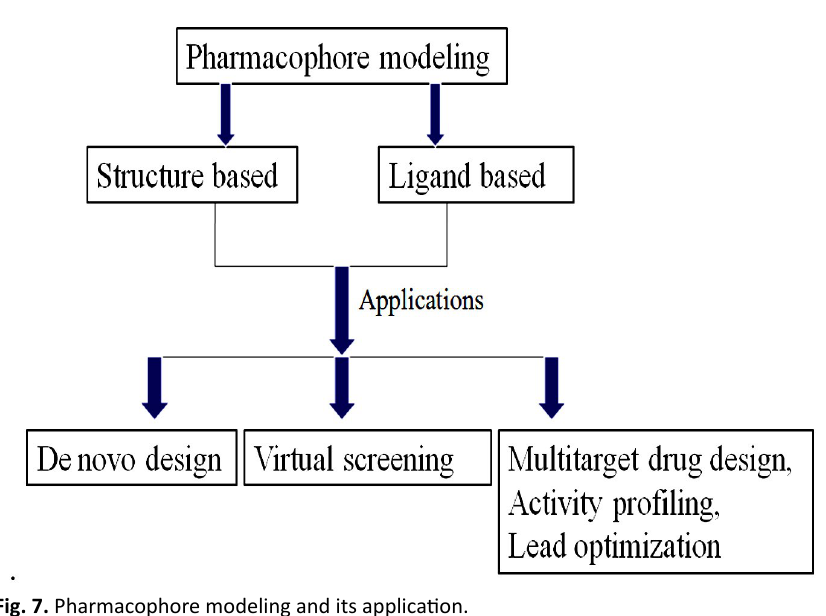
Fig. 7. Pharmacophore modeling and its